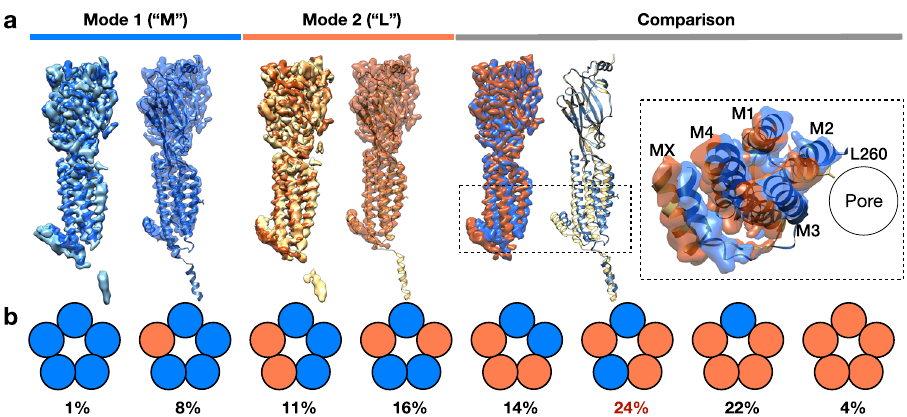
Fig. 3 Conformational plasticity of serotonin-5HT 3 R-Salipro state. a Classes resulting from symmetry expanded monomer-focused 3D classi fi cation were divided into two groups based on comparison to the serotonin-5HT 3 R-Salipro model: (1) densities similar to chain A/C (corresponding to ‘ Mode 1 ’ in Fig. 2e) or M-type (left, model of chain C is shown), and (2) densities similar to chain B/D/E (Mode 2), or L-type (middle, model of chain D is shown). Superposition of M- and L-types with insert showing a top view (right). b Schematic showing the population of the eight different combinations of serotonin-5HT 3 R-Salipro arrangements; blue and orange circles represent M- and L-type subunits, respectively. The largest class corresponds to the consensus serotonin-bound